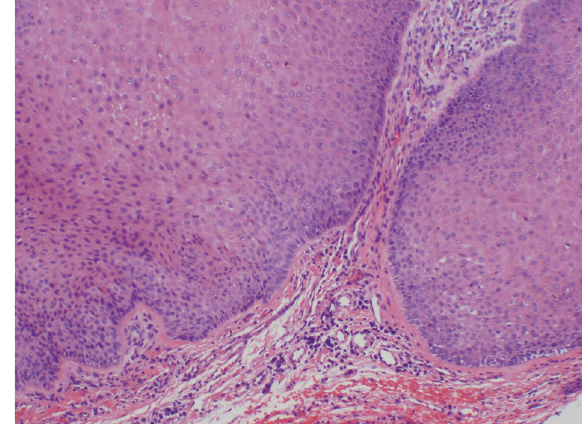
Figure 2: Pushing, noninfiltrating margin of squamous